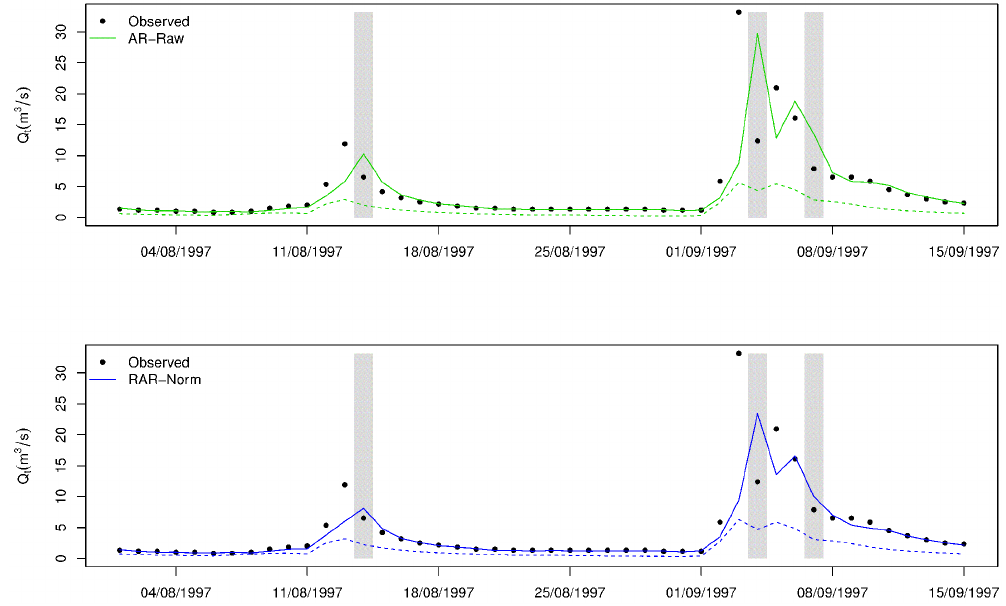
Figure 6. Forecast streamflows for the Abercrombie catchment for the period between 1 Augst 1997 and 15 September 1997. The top panel shows streamflows forecast with the AR-Raw model; the bottom panel shows streamflows forecast with the RAR-Norm model. Dashed lines: forecasts from the base hydrological model (i.e. without error updating). Solid lines: forecasts with error updating. Grey shading denotes instances of over-correction caused by the AR-Raw model.